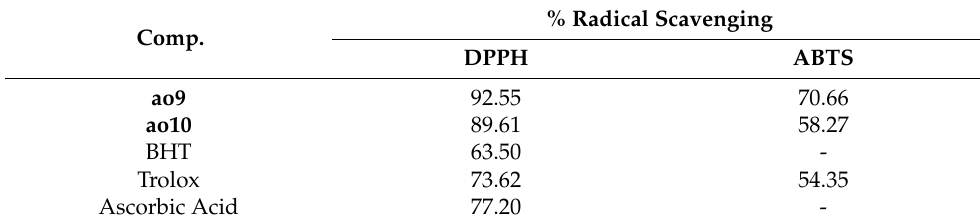
Table 58. Antioxidant screening results of the synthesized compounds ( ao9-ao10 ) by applying the DPPH and ABTS + scavenging